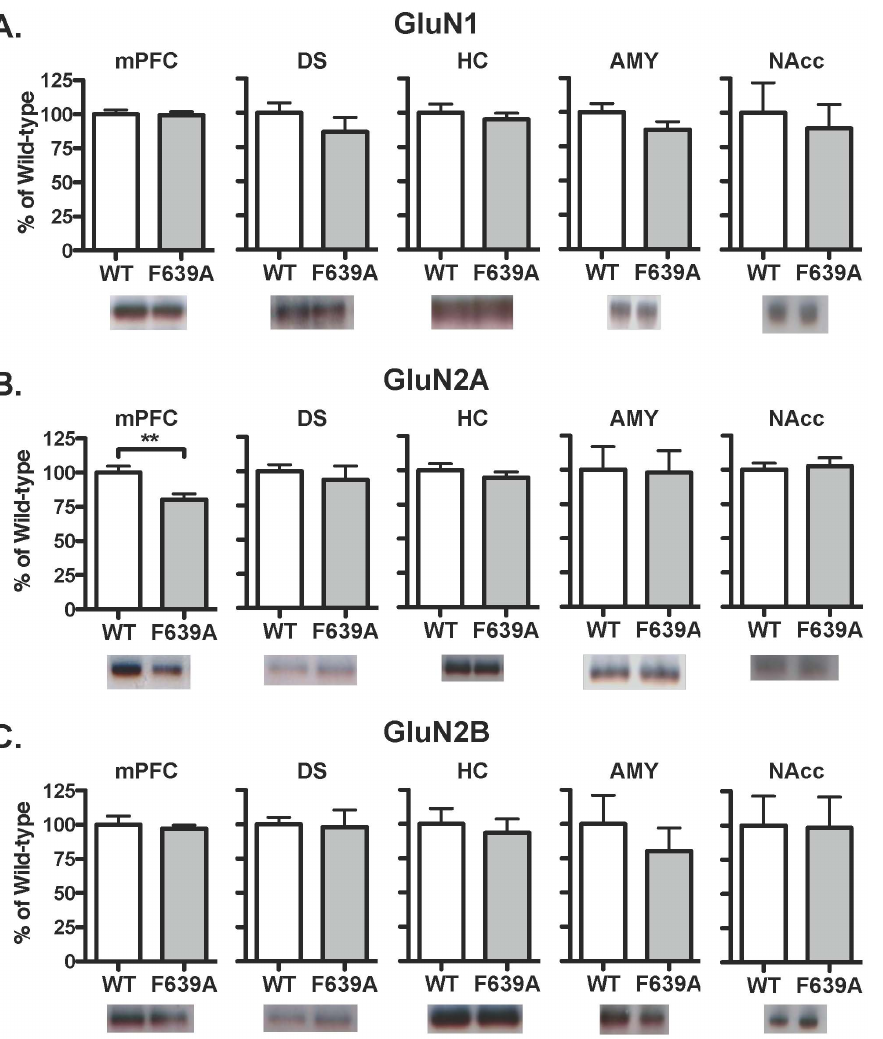
Figure 3. Expression of NMDA receptor subunits in wild-type and F639A Het mice (n=4–5 for each group). Panels show immunoblot analysis of GluN1 ( A ), GluN2A ( B ), and GluN2B ( C ) from crude membrane fractions prepared from select brain regions. Data are percent of wild-type control (mean 6 SEM). Abbreviations: mPFC , medial pre-frontal cortex; DS , dorsal striatum; HC , hippocampus; AMY , amygdala; and NAcc , nucleus accumbens. Symbol ( * ): value significantly different from control ( ** p , 0.01, unpaired t